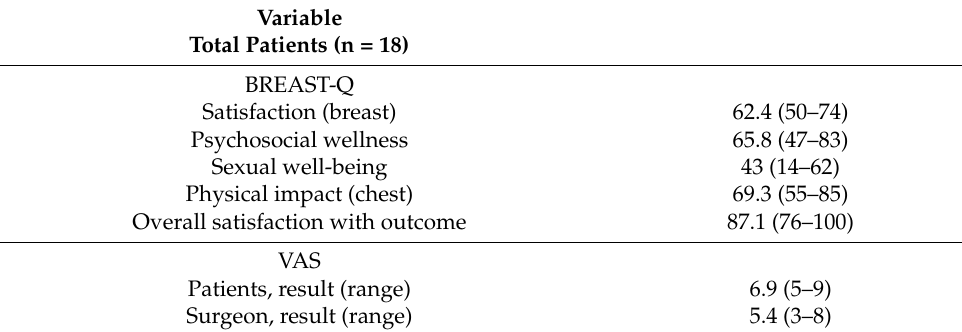
Table 2. Post-operative